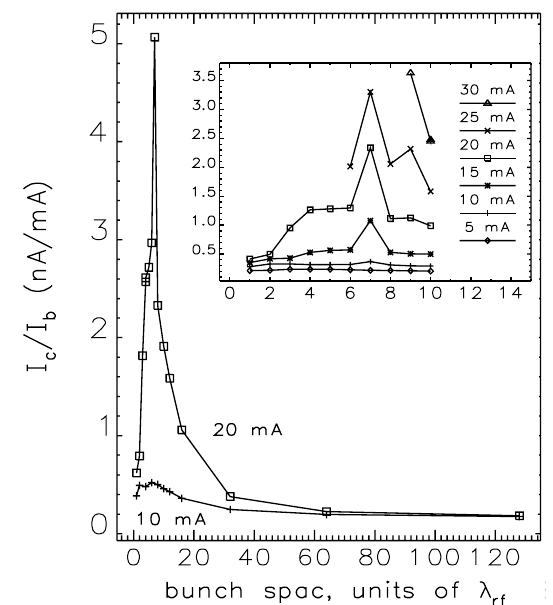
FIG. 9. Comparison of normalized electron current as a func- tion of bunch spacing and bunch current (ten bunches, total beam current shown; detector 6). Vacuum pressure rise and only observed for bunch currents above sharp peak at 7 (cid:2) rf about 1.5 mA. Figure inset shows detail around the peak and also shows the effect of surface conditioning, having been acquired after an additional 60 Ah of beam